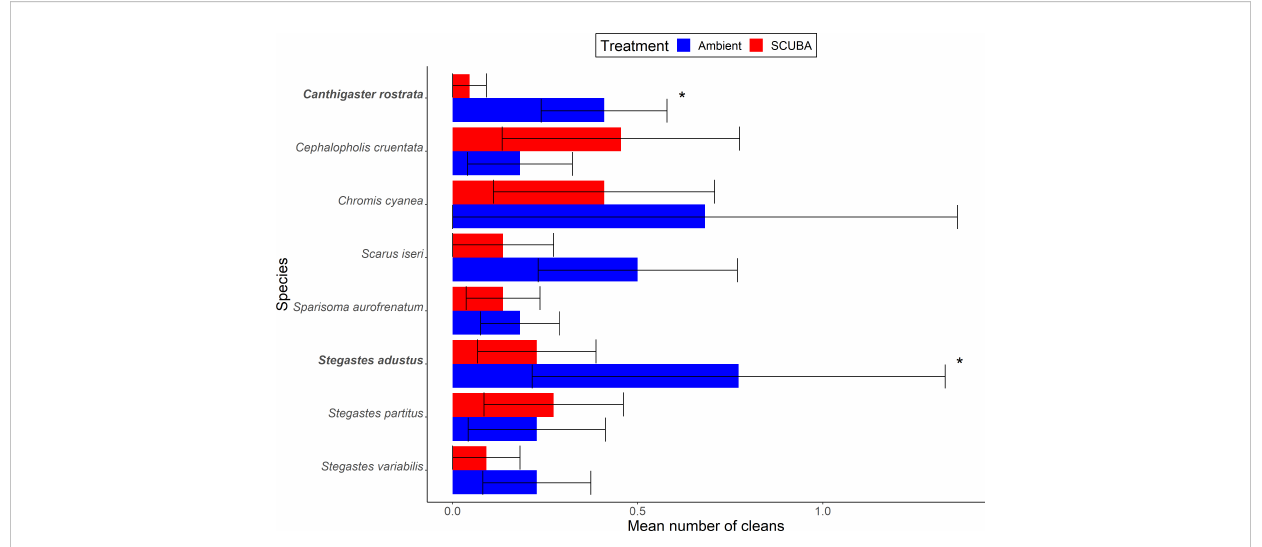
FIGURE 5 Client occurrences, identi fi ed to species level, during the two acoustic treatments (playback of ambient sound or SCUBA noise). Shown are mean ± SE number of cleans of fi shes for species above the occurrence threshold (> 1%). * p < 0.05. N = 22 cleaning